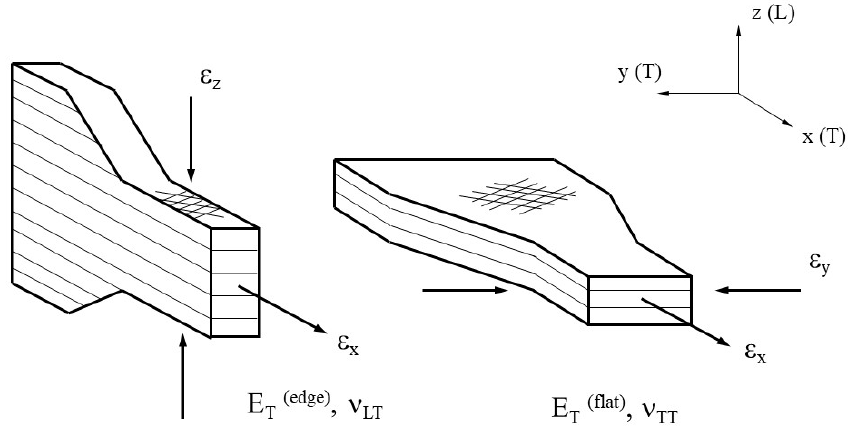
Figure 5. Flat and edge configurations of tensile specimen to determine E T(edge) , E T(flat) , ν LT , and ν TT .